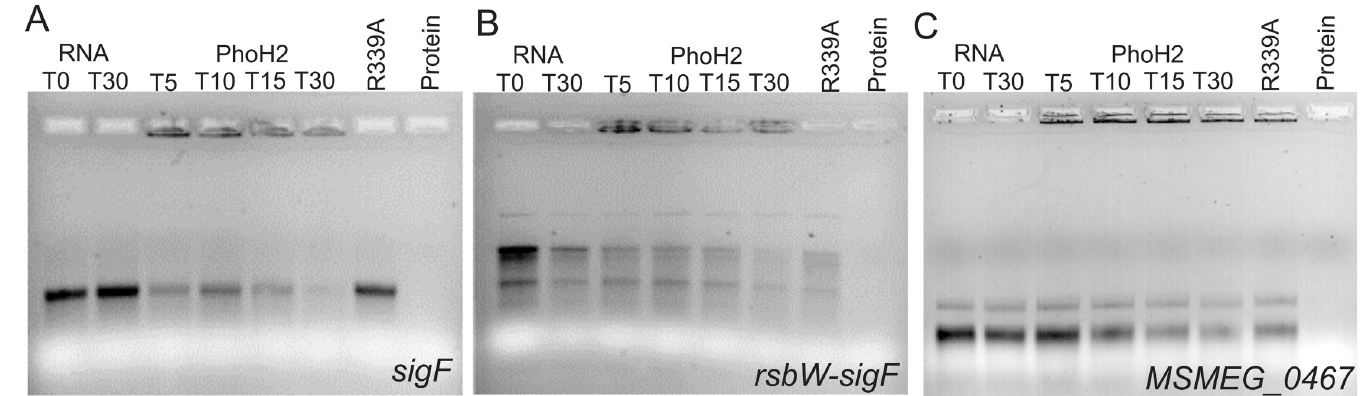
Fig 4. PhoH2 acts on sigF RNA. (A) sigF , (B) rsbW-sigF and (C) MSMEG_0467 RNA transcripts were assayed with PhoH2 over time. RNA unwinding and degradation by PhoH2 of sigF RNA is shown by the decrease in RNA intensity with an increase in smearing of the RNA to elimination over time in the presence of PhoH2 compared with RNA only. RNA binding by PhoH2 is evident by retardation of the RNA in the wells. No activity was observed by PhoH2-R339A (RNA helicase mutant) [10] when used in place of PhoH2. (B) rsbW-sigF RNA shows intrinsic decay as shown by the loss in intensity of the RNA only control at T30. At the same time point (T30), in the presence of PhoH2, there is a greater loss of integrity with increased smearing suggesting degradation by PhoH2 of this RNA. In the presence of R339A there is some aspecific degradation. (C) There was no loss of the integrity of MSMEG_0467 RNA as evidenced by the retention of RNA integrity over the time course. Reactions/ labels: RNA only at T 0 and T 30 —RNA (25 μ M) incubated in reactions containing 5 mM ATP made up to 15 μ l with assay buffer (50 mM tris pH 7.5 20 mM NaCl 5 mM MgCl 2 ) at 37˚C. T 5 , T 15 , T 30 —RNA + PhoH2 (125 μ M)—incubated in reactions as above for 5, 15 or 30 minutes. R339A - RNA + PhoH2-R339A in place of PhoH2. Protein—protein only. Reactions were analysed by 1.5% TAE